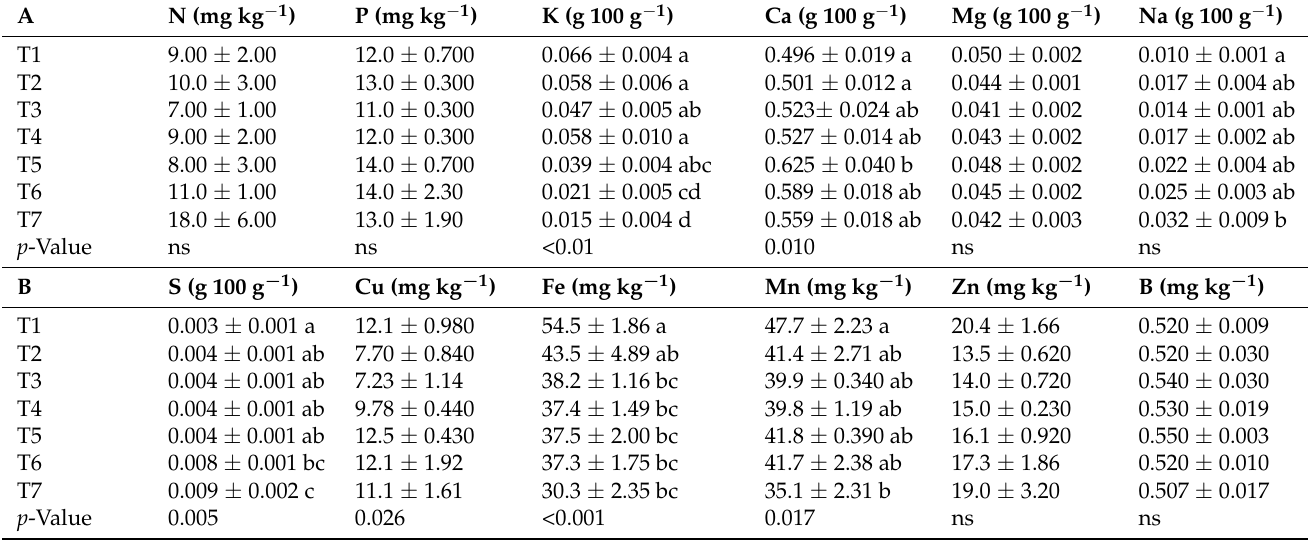
Table 7. Nutrient concentration in potting mix with addition of UWP at seven rates at the end of the